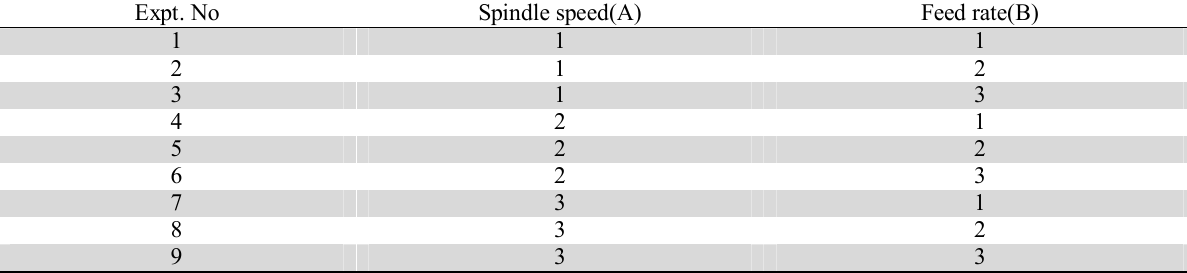
Experimental layout using an L orthogonal array 9 Expt. No Spindle